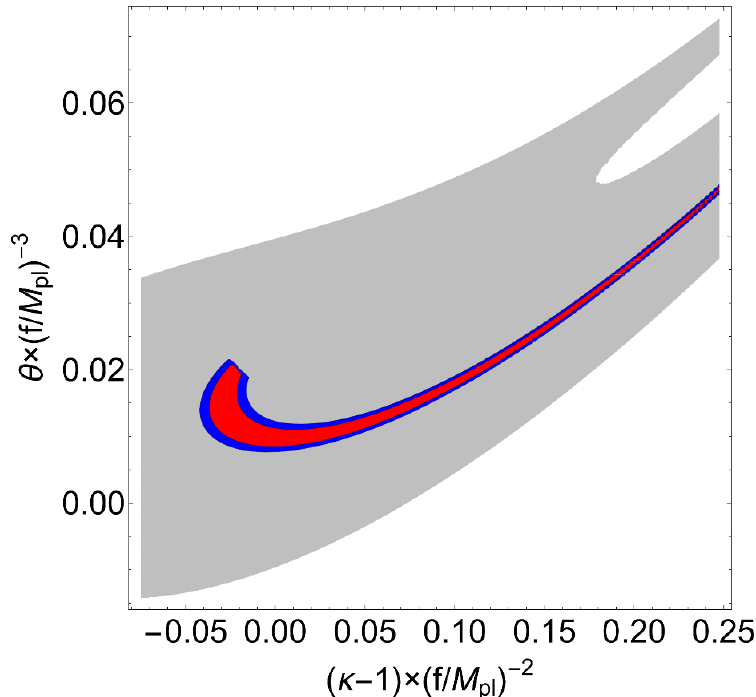
Figure 1 . In the red and blue shaded regions the CMB constraints (2.16) are satis(cid:12)ed at 1 (cid:27) and 2 (cid:27) , respectively. We have set n = 3 and f = 10 7 GeV, and normalized (cid:18) and (cid:20) (cid:0) 1 by their typical values for convenience. In the gray region j (cid:17) ( (cid:30) (cid:3) ) j < 0 : 1 is